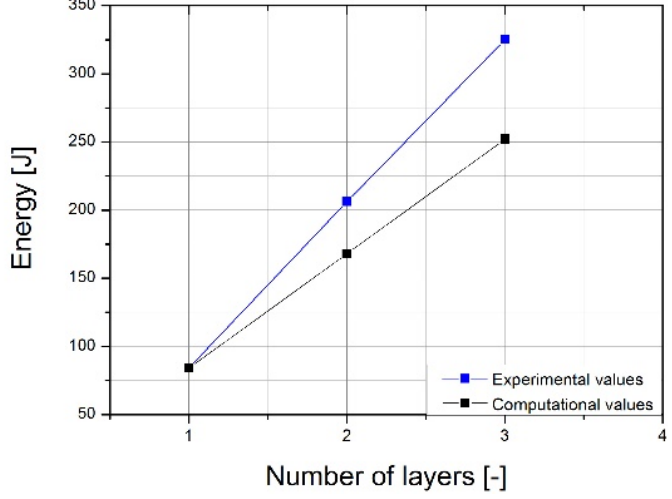
Figure 13. The dependence of energy during puncture on the number of layers of the sheet for the value measured during the experiment and the calculation value.